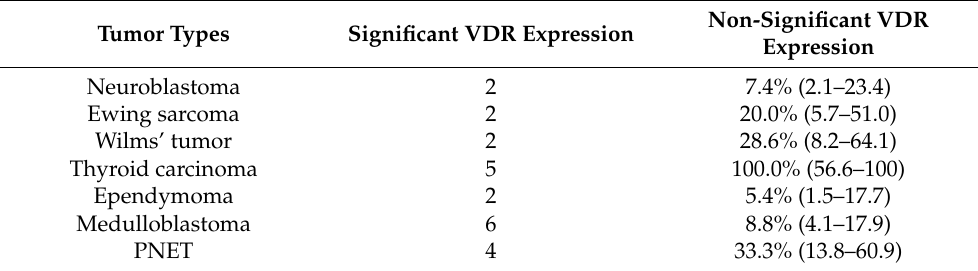
Figure 2. Proportion of vitamin D receptor expression levels for different diagnoses with 95% confi- dence intervals (VDR: vitamin D receptor; TGC: thyroid gland carcinoma; WT: Wilms’ tumor; PNET: primitive neuro-ectodermal tumors; EWS: Ewing sarcoma; NBL: neuroblastoma; MBL: medulloblas- toma; EPM: ependymoma). Table 2. The table below lists the examined tumor types. Case numbers in each category are shown in the second column. Significant and non-significant VDR expression rates with 95% confidence intervals are shown in the third column by tumor type.